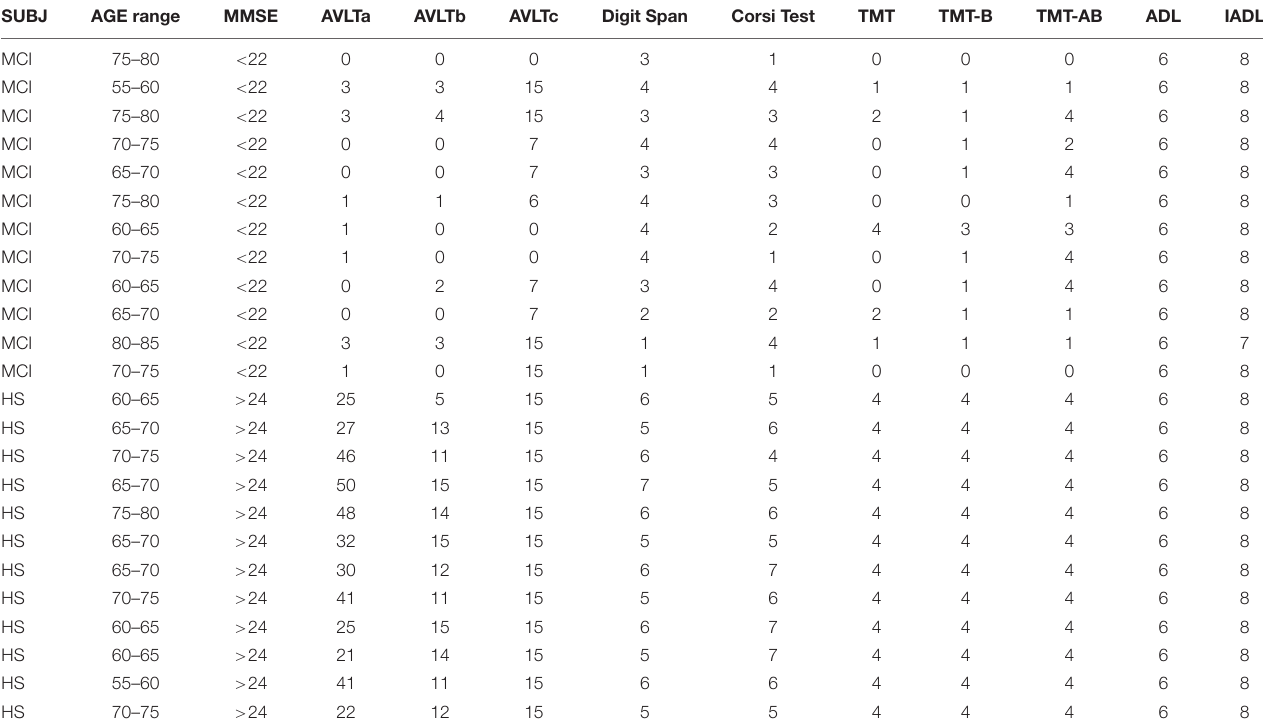
TABLE 1 | MMSE, Rey Auditory Verbal Learning Test (AVLT), Digit Span Test, Corsi Spatial Test, and Trial Making Test (TMT) scores. SUBJ AGE